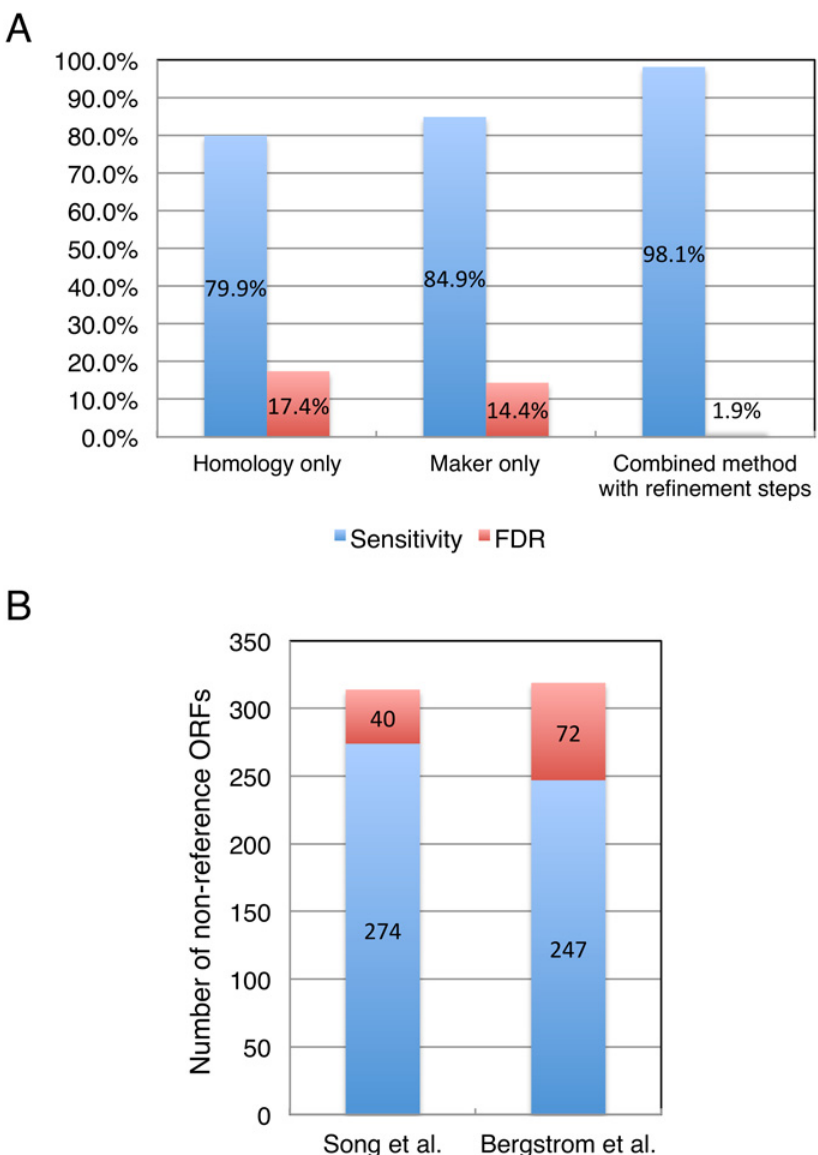
Fig 2. Pipeline validation based on annotation results. (A) Annotation accuracy of the pipeline is measured using the reference genome assembly as input. Whereas 80% of ORFs predicted by homology only are correct and 85% by MAKER only, our combined method with refinement steps predicts 98% of ORFs correctly. In terms of FDR, the combined method also shows better performance than the homology only or the MAKER only methods alone. (B) Annotation comparison of our non-reference ORFs to Bergstrom et al . [17] shows that 77% of 319 non-reference ORFs from Bergstrom et al . are commonly found in our results from 18 non-S288C strains. We identify 40 non-reference ORFs that were not identified by Bergstrom et al . [17] while Bergstrom et al . identify 72 non-reference ORFs not found in our study; these are presumably due to the non-overlapping strains among the sets of strains used in the two